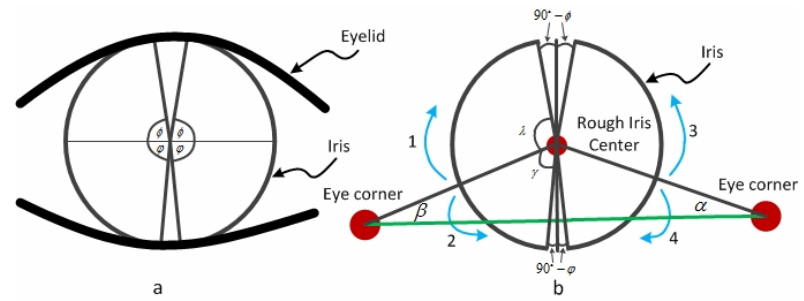
Figure 8: (a) shows angels (cid:73) and (cid:77) considered for the iris edge detection ranges free from eyelids occlusion. (b) shows directions of iris edge detection marked with four blue arrows labeled 1, 2, 3 and 4. (cid:79) and (cid:74) represent the search angels between initial search line (See Figure 10b) and maximum search boundaries.